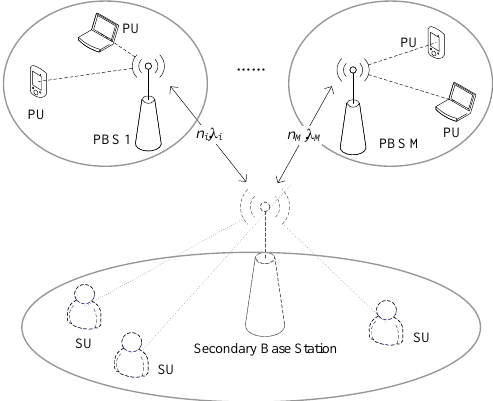
Figure 1. The model of multi-primary networks and a secondary network.